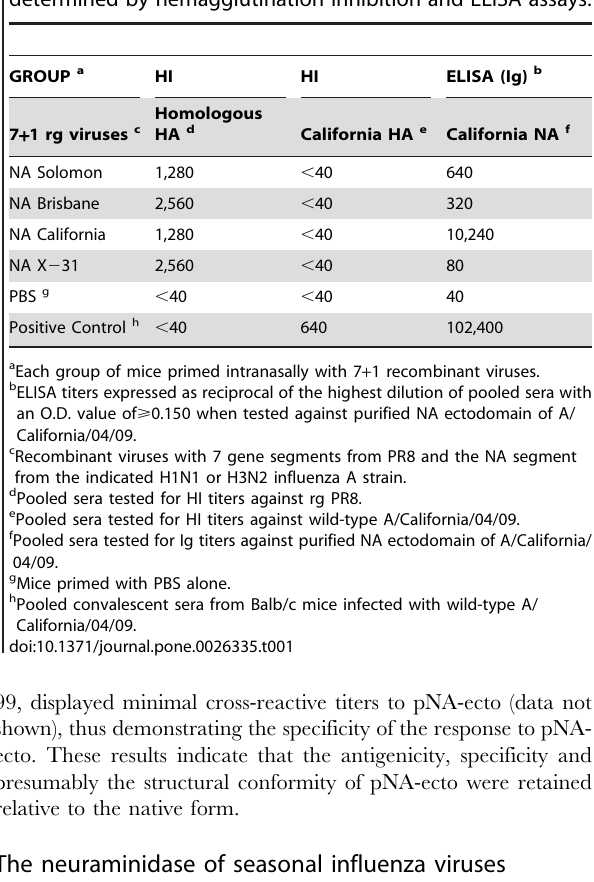
Table 1. Serum antibody titers in Balb/c mice after priming with reverse genetic 7 + 1 NA recombinant viruses as determined by hemagglutination inhibition and ELISA assays.